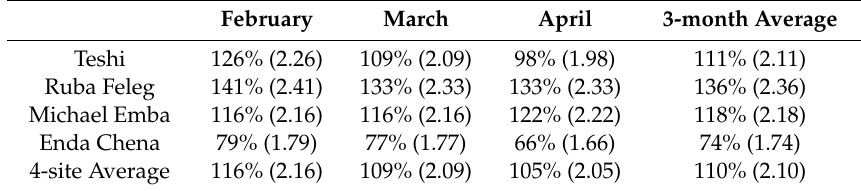
Table 8. Percent of increases of SWC in the four sites of analysis. In parenthesis the value of